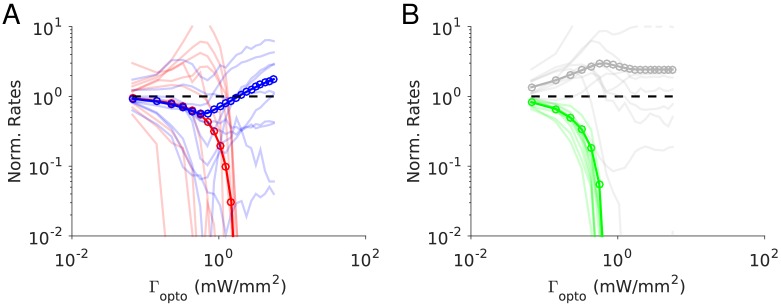
Numerical simulations of Model 2.Responses of the neurons normalized to baseline vs. the intensity of the laser, Γopto. (A) Activities of PCs and PV neurons: for small Γopto, the PV response is paradoxical and the suppression of the PC and PV population activities relative to baseline are the same. (B) Activities of SOM and X neurons. Color code as in Figure 9. Thick lines: population averaged responses. Thin lines: responses of 10 neurons randomly chosen in each population. Firing rates were estimated over 100s. Parameters: K = 500, N = 76800. Other parameters as in Tables 6–7. The baseline activities are: rE = 4.2 Hz, rI = 6.8 Hz rS = 7.0 Hz, rX = 3.9 Hz.